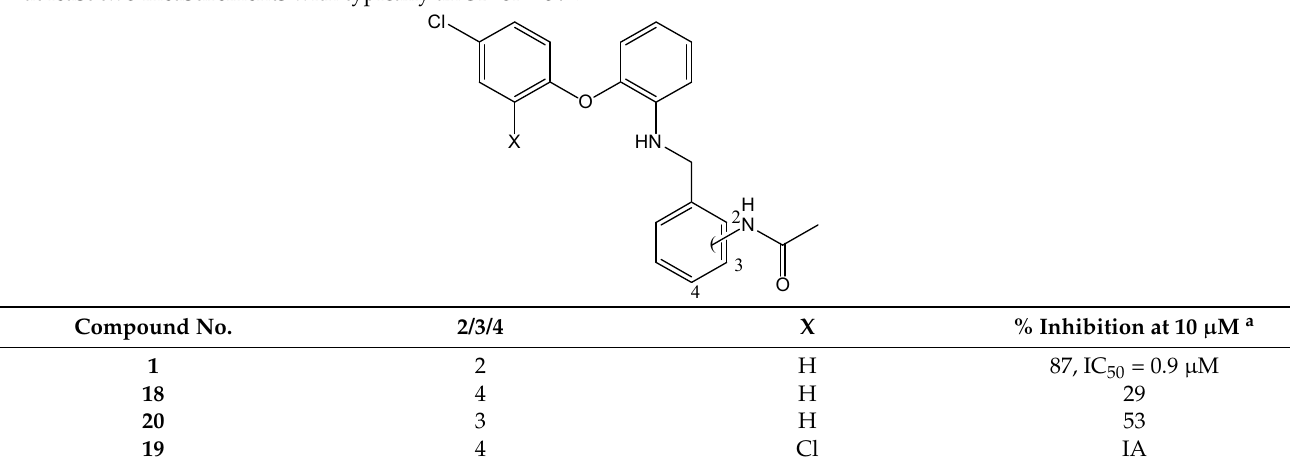
Table 3. Biological data for compounds with a migrated N -acetamide group; a results obtained from the TLC assay. Mean of at least two measurements with typically an SD of ±5%.